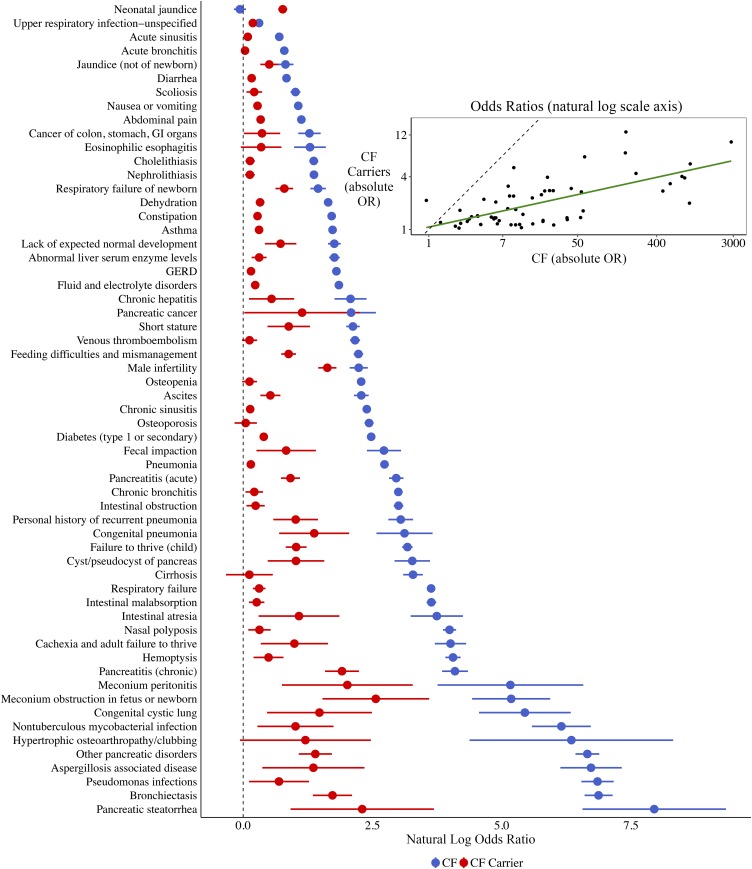
The prevalence of CF-related conditions is correlated between CF carriers and subjects with CF relative to control subjects. In the main figure, natural log ORs and corresponding 95% CIs are plotted for the various conditions for CF carriers (red) and subjects with CF (blue), ordered by the natural log OR for subjects with CF. The inset at the upper right shows a scatterplot of these values. The slope of the trend line (green) between conditions in CF carriers and subjects with CF is 0.22 (P < 0.001); the natural log OR of a given condition in CF carriers is ∼22% of the natural log OR in subjects with CF. The Pearson correlation between natural log ORs in the 2 cohorts across the conditions is 0.67 (P < 0.001).